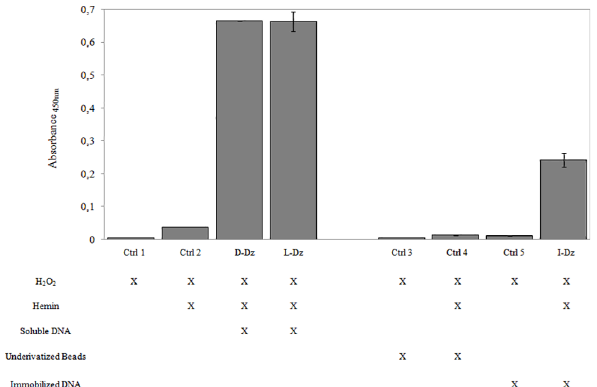
Fig 3. Oxidation of TMB catalyzed by D-DNAzyme (D-Dz), L-DNAzyme (L-Dz) an immobilized DNAzyme (I-Dz). Final concentrations were 10.5 μ M DNAzyme, 0.16 mM TMB and 0.8 mM H 2 O 2 . Reactions were stopped after 15 minutes by addition of acid. Absorbance was measured at 450 nm.